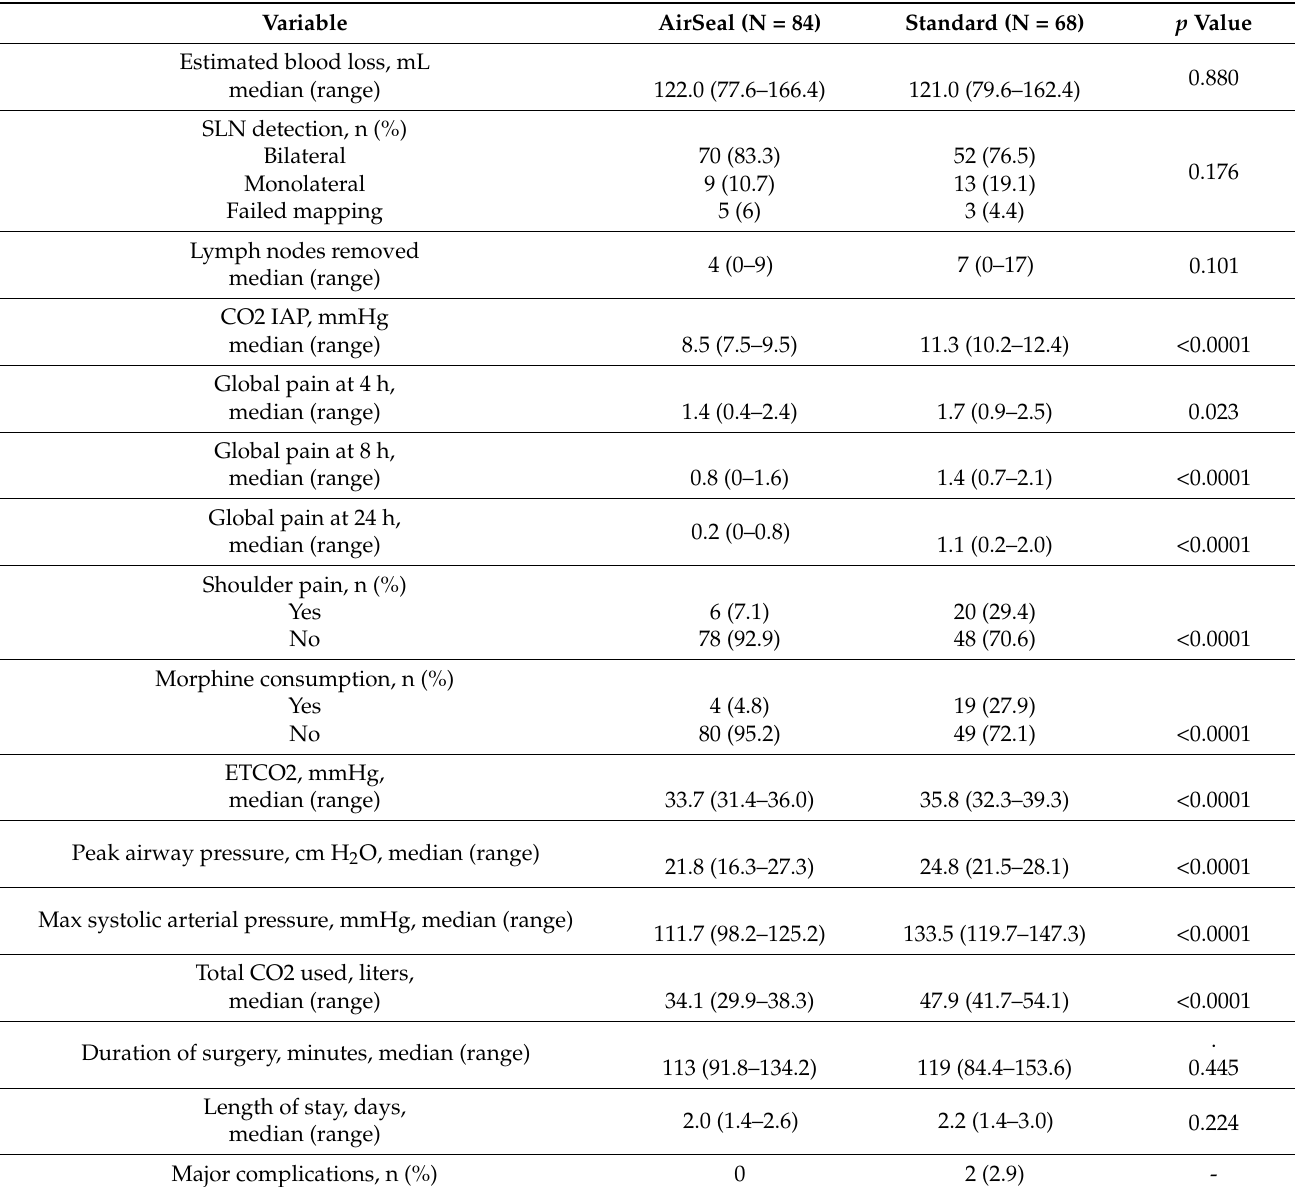
Table 2. Surgical and anaesthesiology